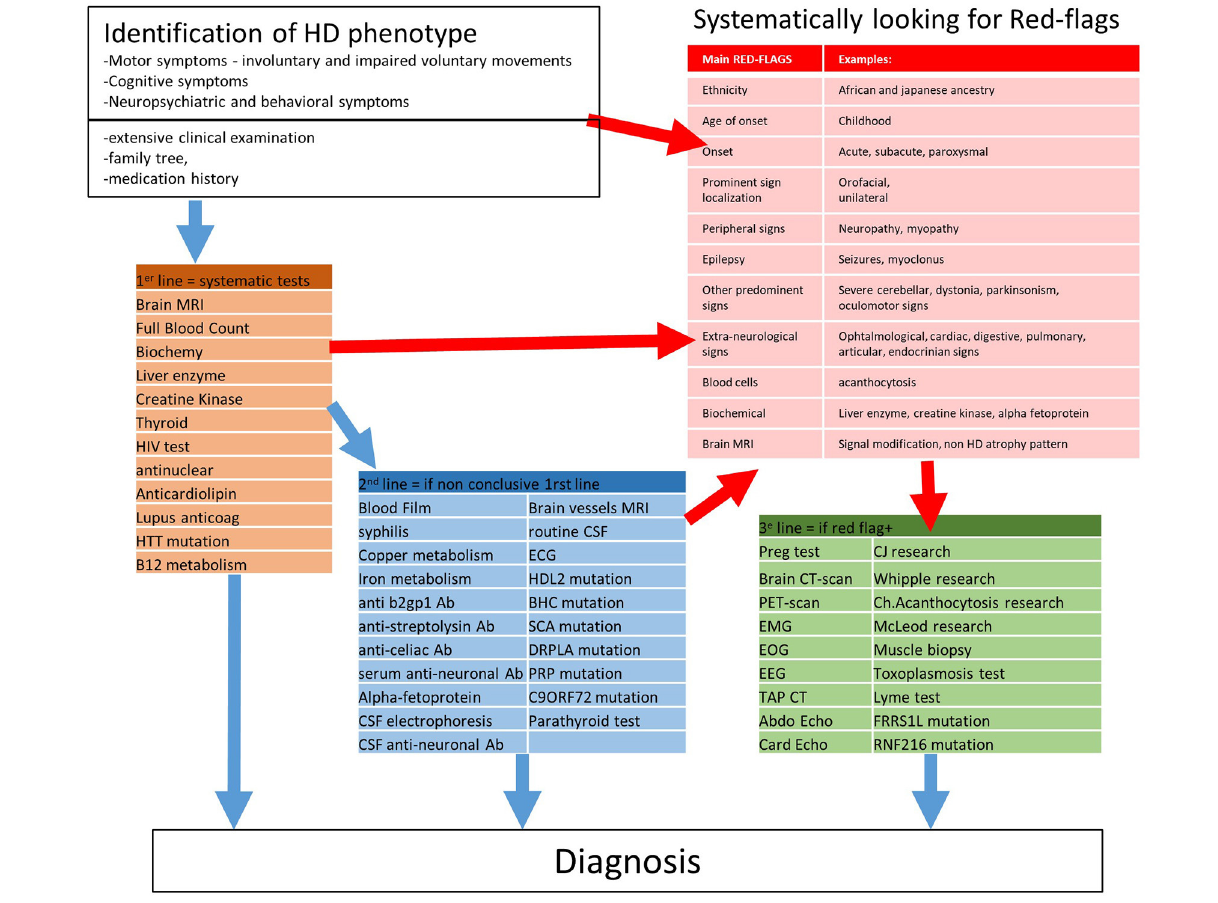
FIGURE 3 | Proposition of a strategy to diagnose HD phenocopy. Ab, Antibodies.